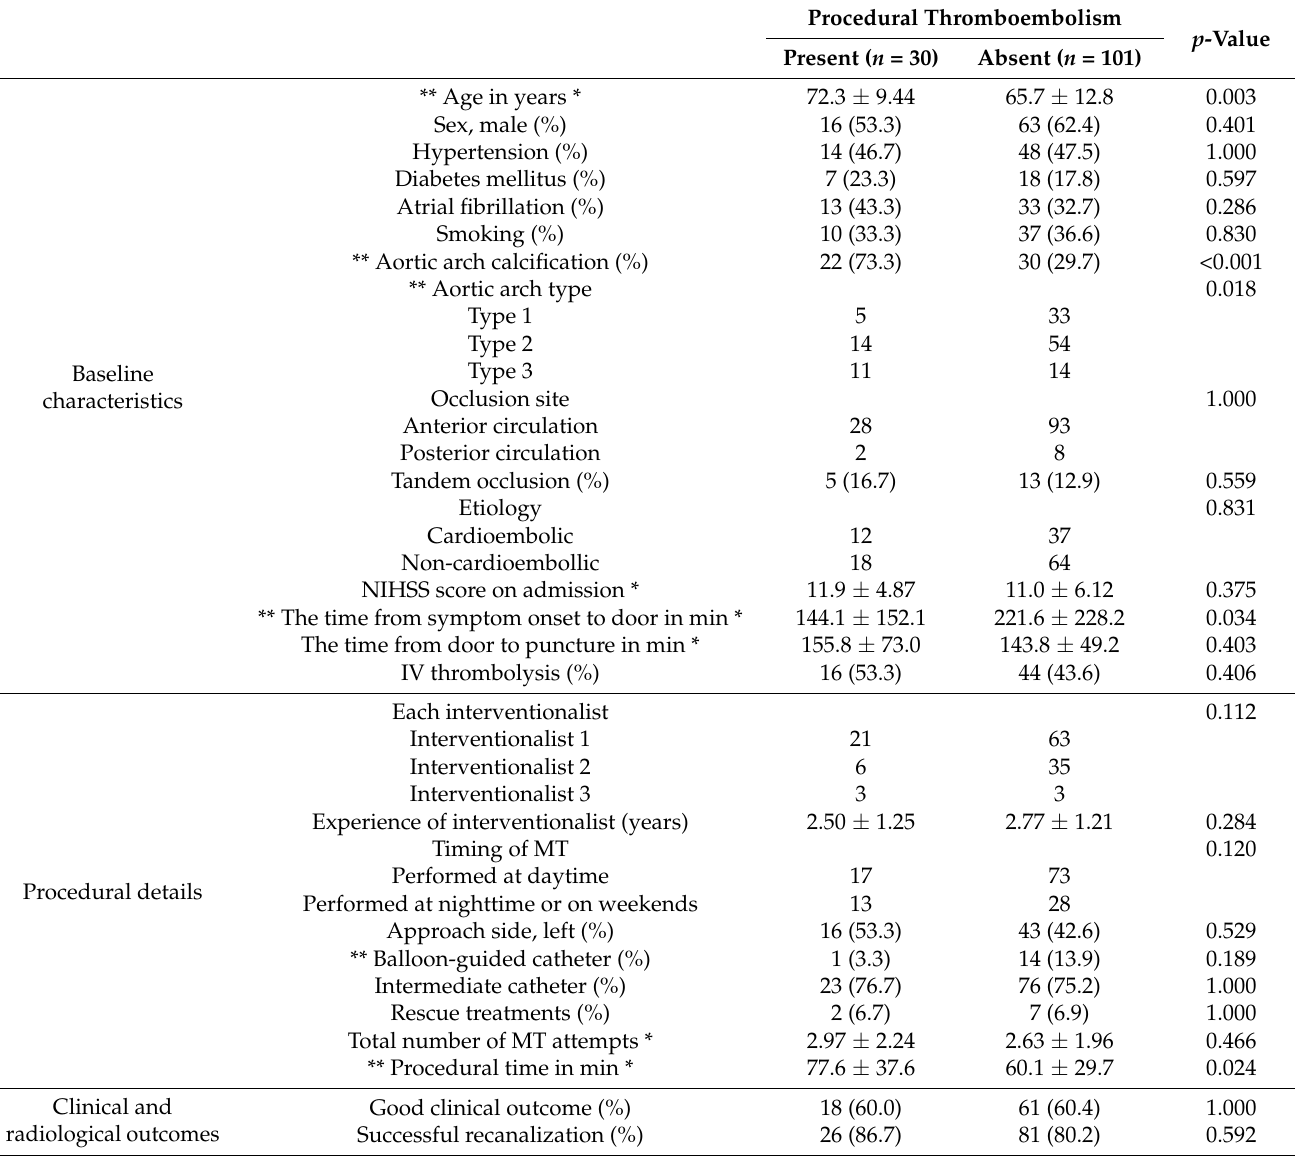
Table 2. A comparison of patients with and without procedural thromboembolism after mechanical thrombectomy for acute ischemic stroke.